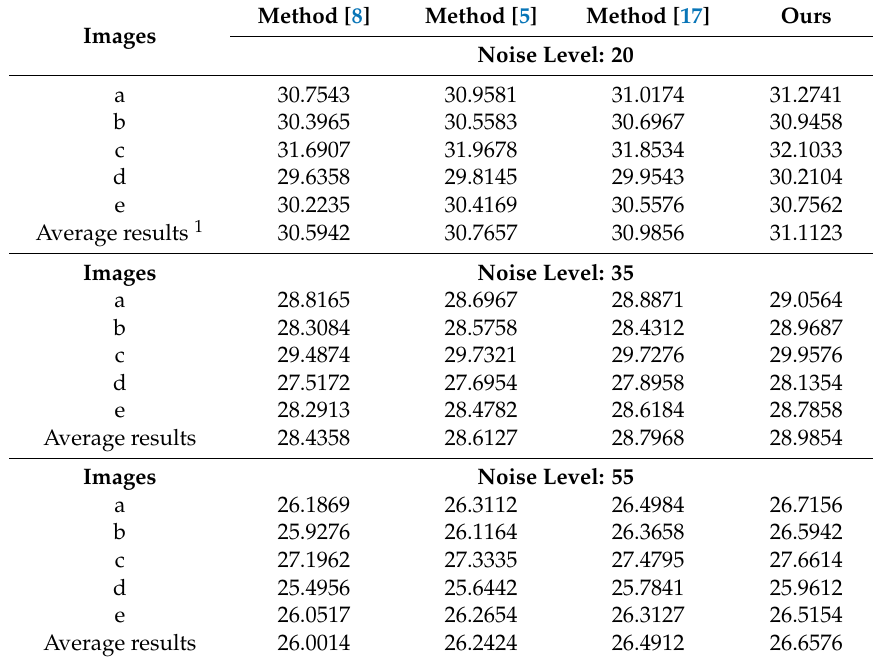
Table 1. Quantitative measurement results using PSNR (dB) on UAV testing images with different noise